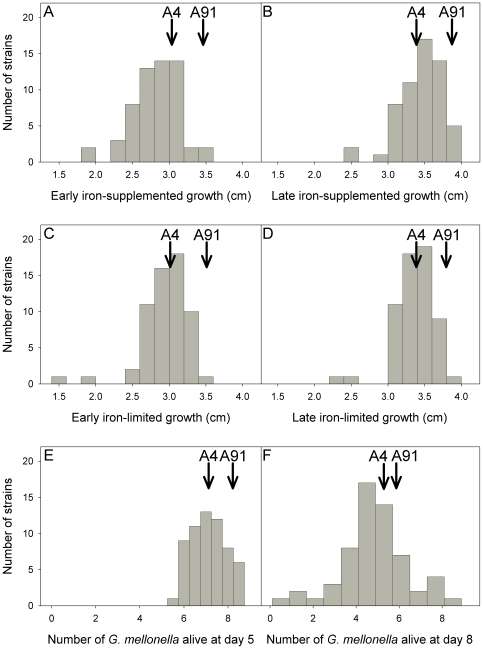
Phenotypic distributions of traits measured in 61 unique progeny genotypes.(A) early iron-supplemented growth, (B) late iron-supplemented growth, (C) early iron-limited growth, (D) late iron-limited growth, and number of G.mellonella alive at (E) 5-days post injection and at (F) 8-days post injection.